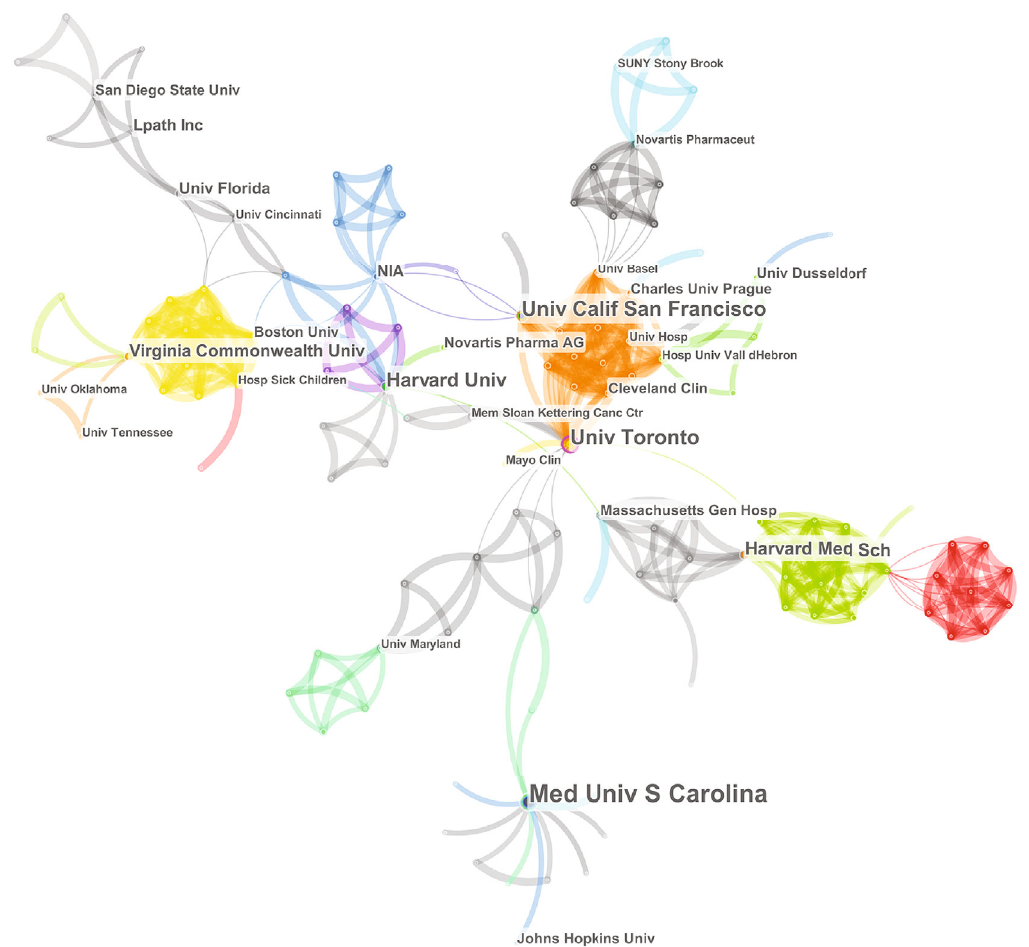
Figure 4: Institutions linked to S1P and its application in age-related